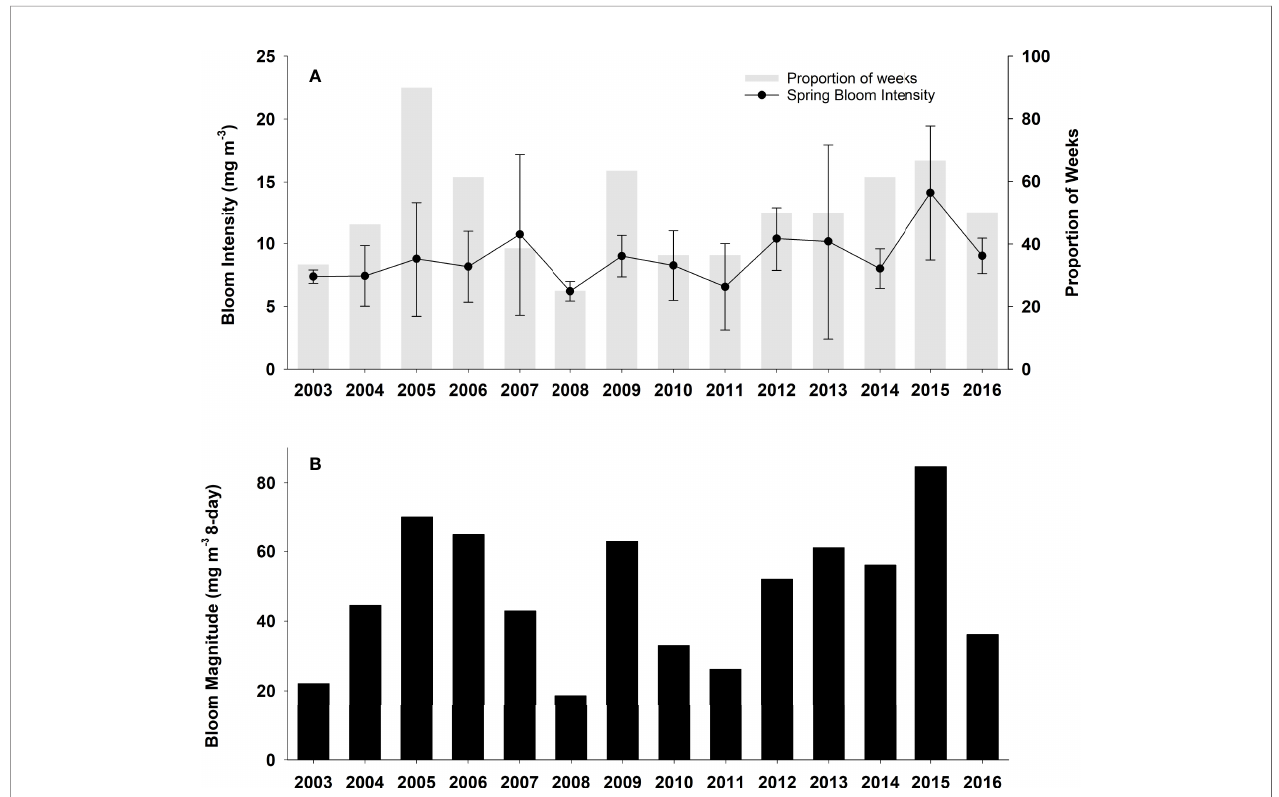
FIGURE 3 | (A) Satellite-derived Chl a spring bloom intensity (line) and proportion of weeks under bloom conditions (grey bars) and (B) spring bloom magnitude (which considers the intensity plus the number of weeks in bloom conditions) from 2003 to 2016 in the Central Strait of Georgia,